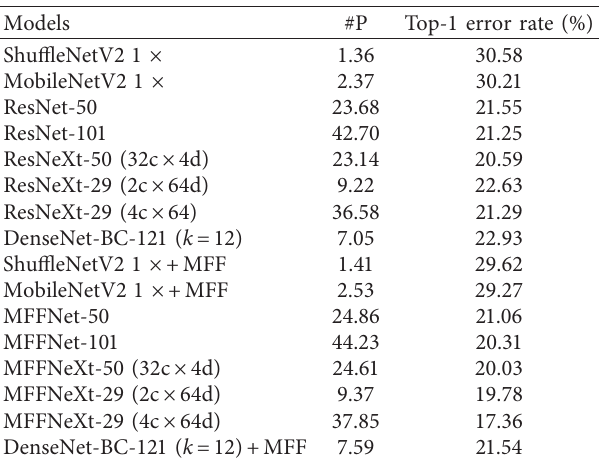
Figure 6: Top-1 testing error rate versus number of epochs for Tiny ImageNet. The numbers of parameters for SKNet-29 (16c × 32d) and MFFNeXt-50 (32c × 4d) are 27.45M and 25.43M, respectively. Table 3: Single 224 × 224 cropped top-1 error (%) and complexity comparisons on CIFAR-100. Atrous rate r � 1 , 2 , 3 { } .